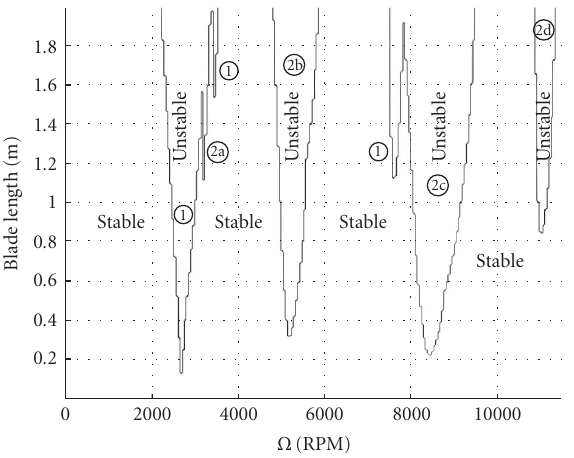
Figure 10: Stability map of a two-bladed rotor as a function of its blade length and its rotational speed.